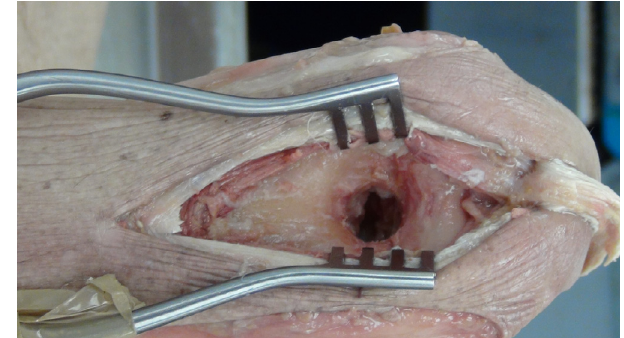
Figure 1. Exposure of triceps